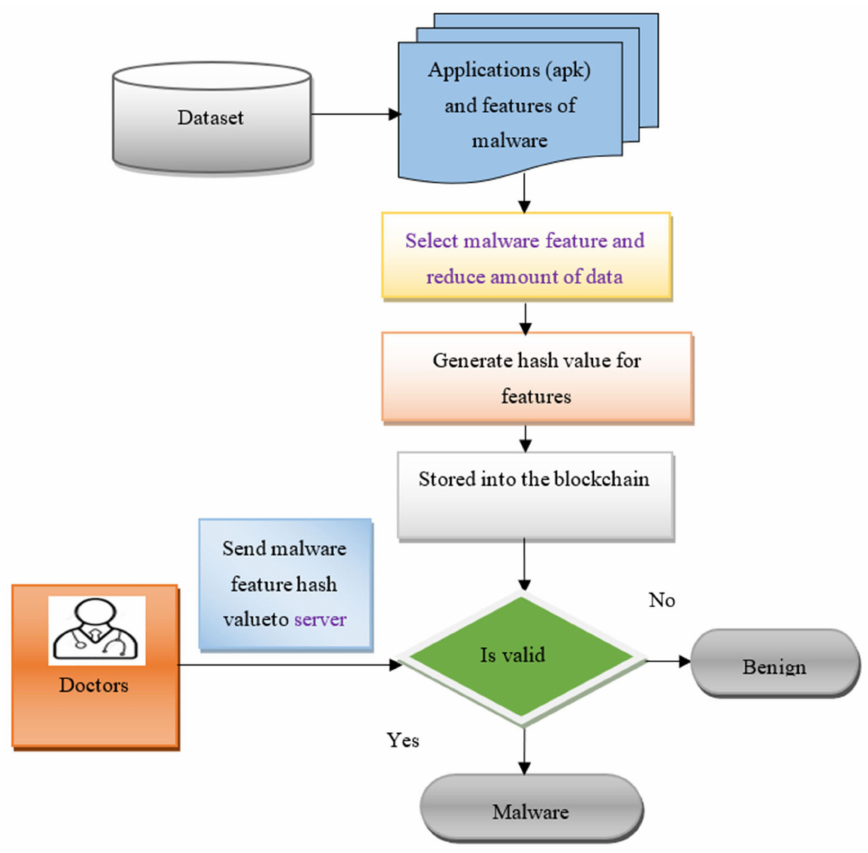
Figure 2. Flowchart of the Biserial Correlative Miyaguchi–Preneel Blockchain-Based Ruzicka-Index Deep Multilayer Perceptive Learning (BCMPB-RIDMPL)